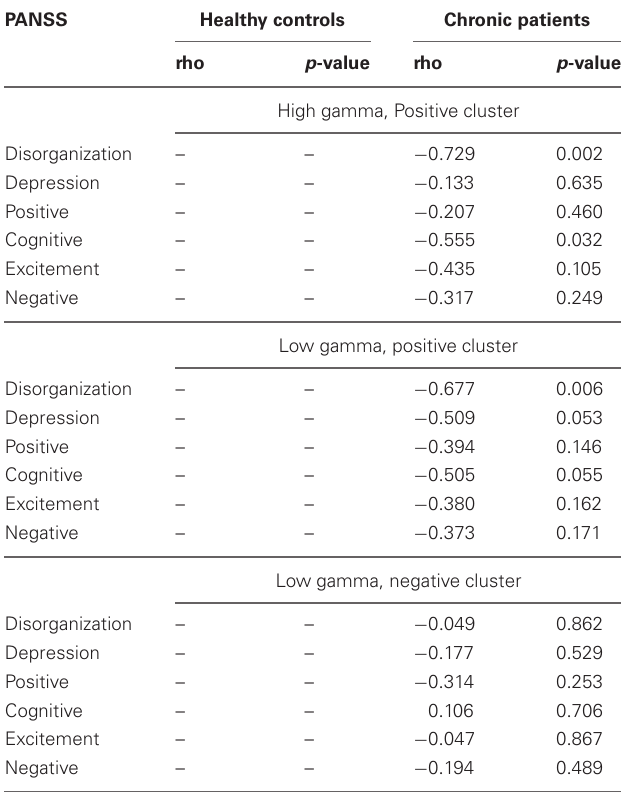
Table 3 | Correlations between gamma-band power and clinical symptoms.